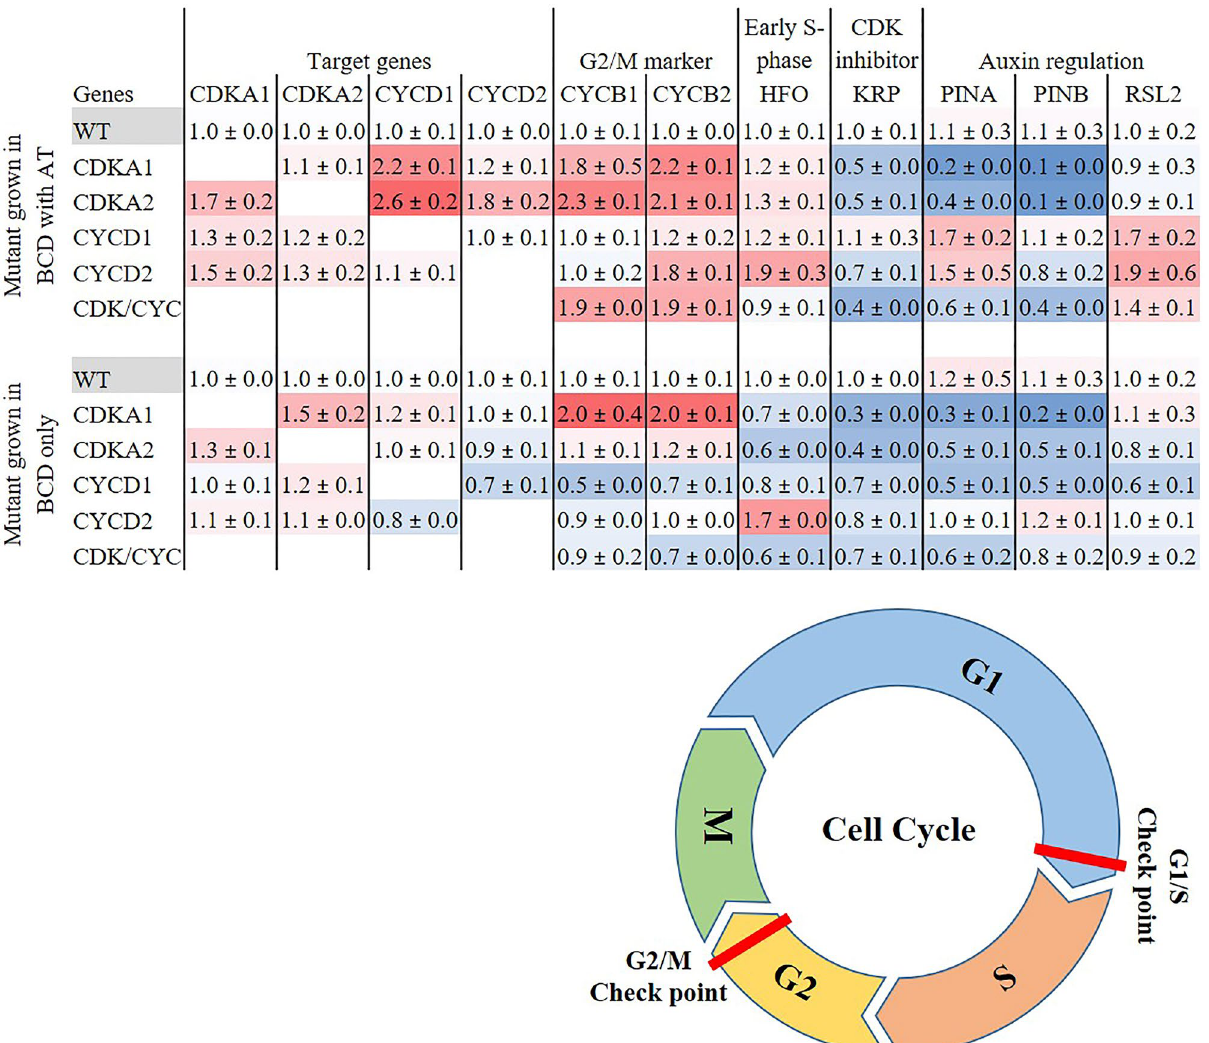
Figure 2. Heat Map of relative expression of cell cycle and cell development markers in mutant lines normalized to actin and tubulin. All cell lines, ZmUbi:PpCDKA1 (CDKA1) , ZmUbi:PpCDKA2 (CDKA2) , ZmUbi:PpCYCD1 (CYCD1) , ZmUbi:PpCYCD2 (CYCD2) , ZmUbi:PpCDKA1-PpCDKA2-OsAct:PpCYCD2- PpCYCD1 (CDK/CYC), are grown in BCDAT and BCD media, respectively. The genes tested are CDKA1, CDKA2, Cyclin B1 and B2 (CYCB1, CYCB2), CYCD1, CYCD2, histone H4 gene (HFO), KIP-RELATED PROTEIN (KRP), auxin efflux carriers PINA and PINB, and auxin-induced transcription factor RSL2. The figure also illustrates the cell cycle phases with the important checkpoints. The G1/S marker is the HFO gene, and G2/M marker is the CYCB1 +